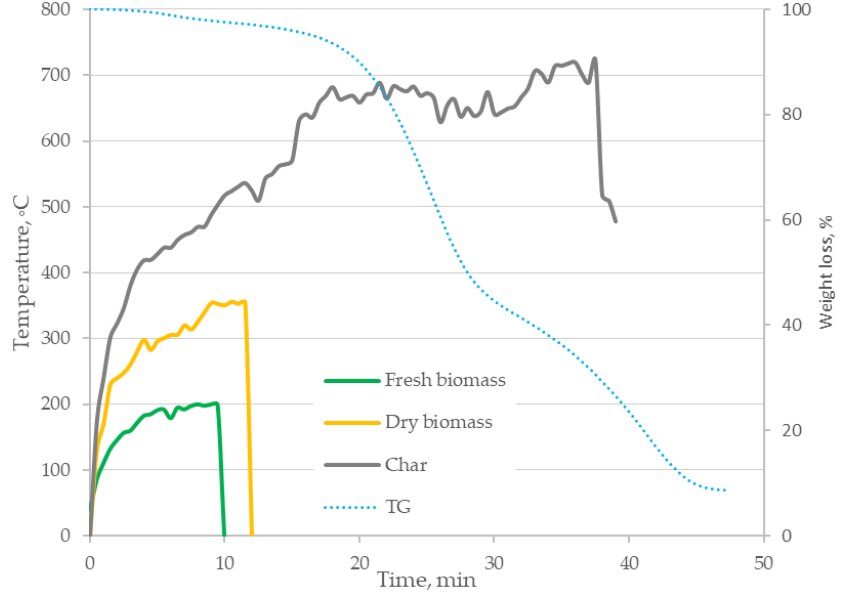
Figure 11. Change in the temperature of fresh biomass, dry biomass and char — sample 50K50J.